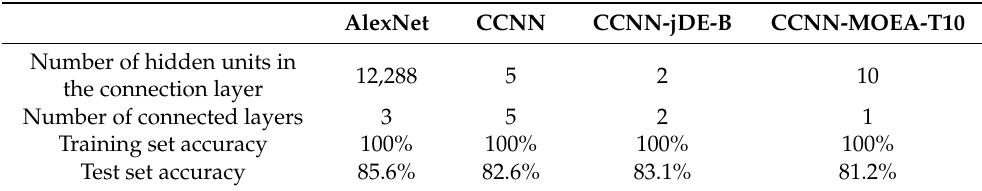
Table 8. The simulation results of the AlexNet pre-training and reconstruction on the CIFAR-10 classification under data augmentation.